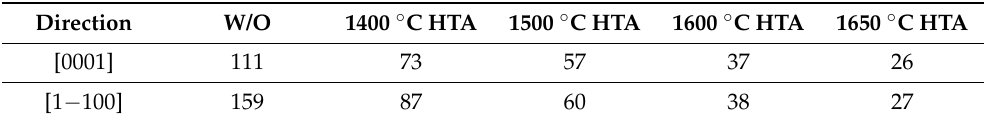
Table 1. The FWHM (arcmin) of non-polar film along two perpendicular directions without and with annealing.